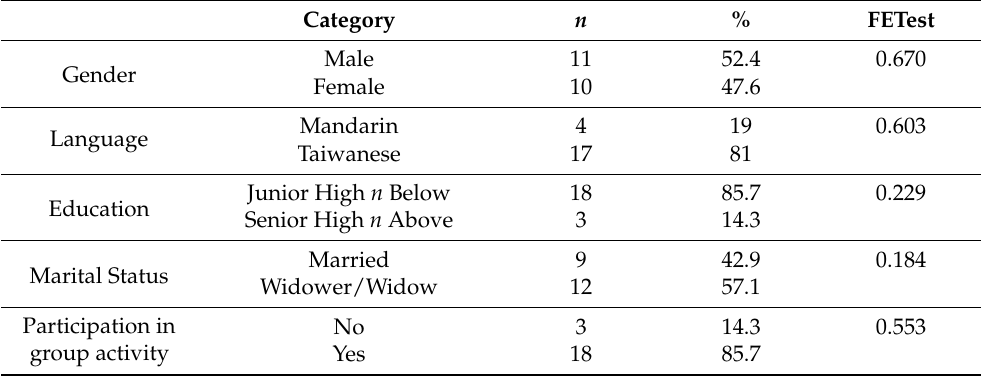
Table 2. Participants basic